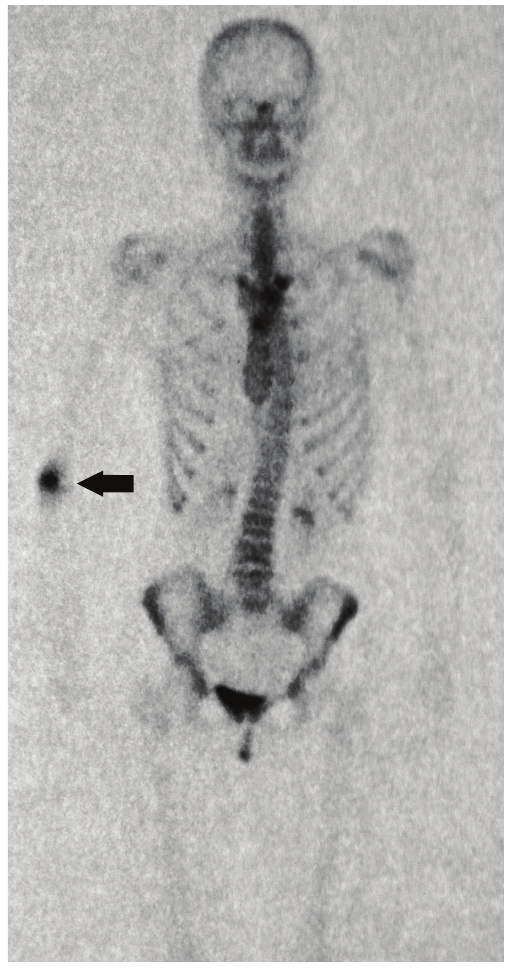
Figure 5: Technetium-99 m bone scan: clearly visible “hot spot” in the distal